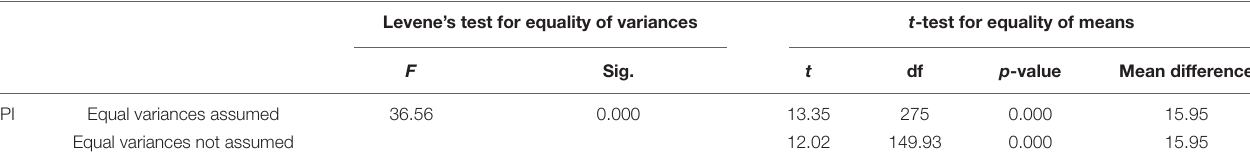
TABLE 5 | Independent sample t -test for experienced and novice teachers’